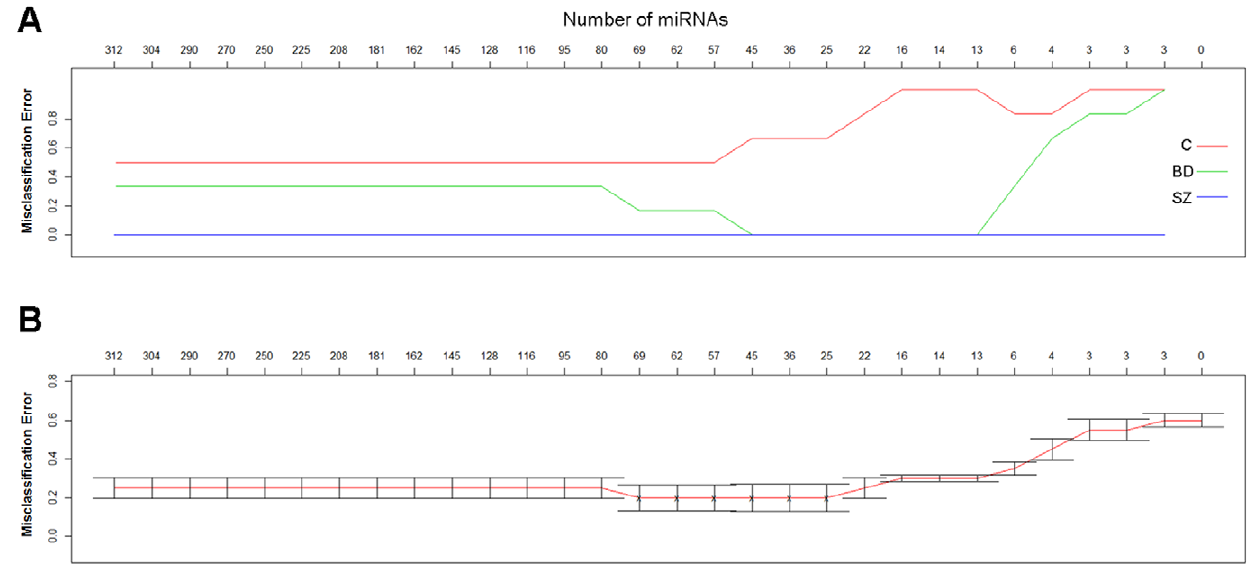
Figure 4. Misclassification rate analysis. (A) Controls (red) have the most variable miRNA expression. The expression data have less variability in BD (green) and the least in SZ (blue; misclassification rate =0), resulting in stronger predictive power within their respective clinical groups.